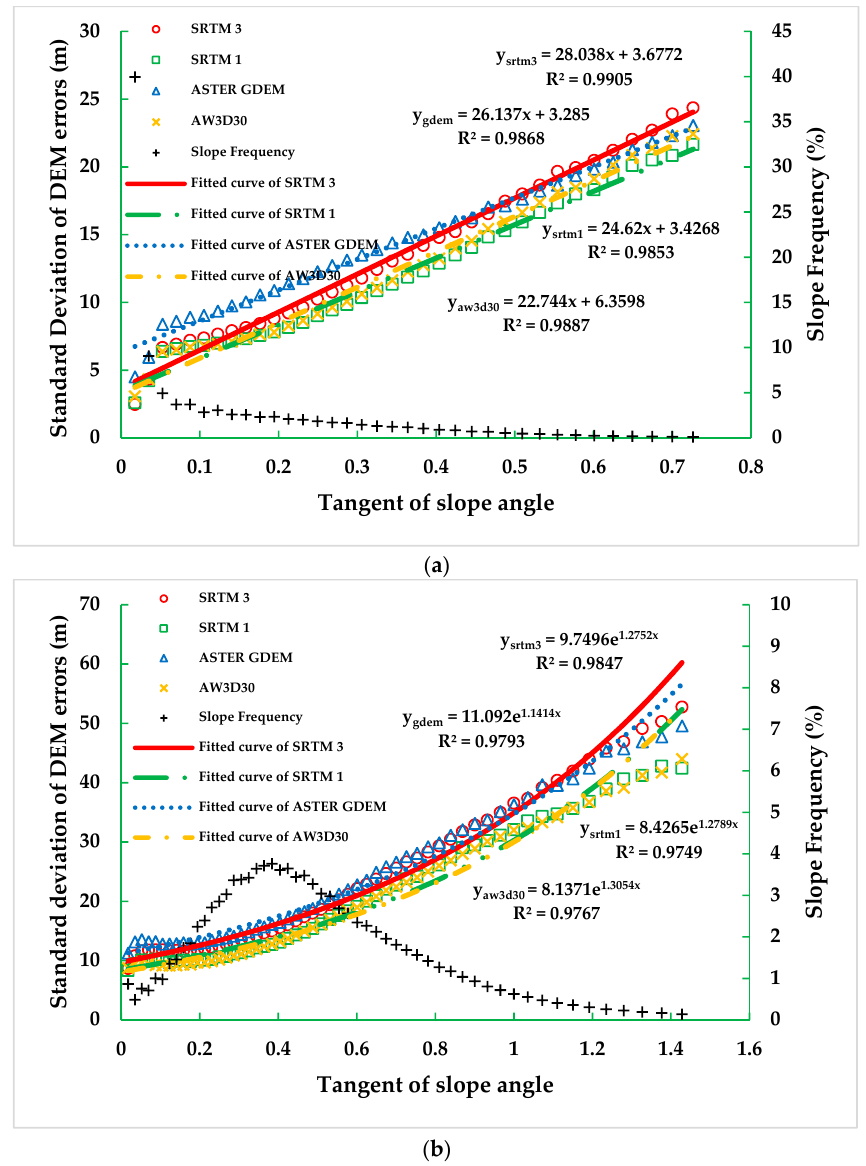
Figure 5. The relationship of standard deviation and slope in ( a ) cultivated land and ( b ) forest areas.